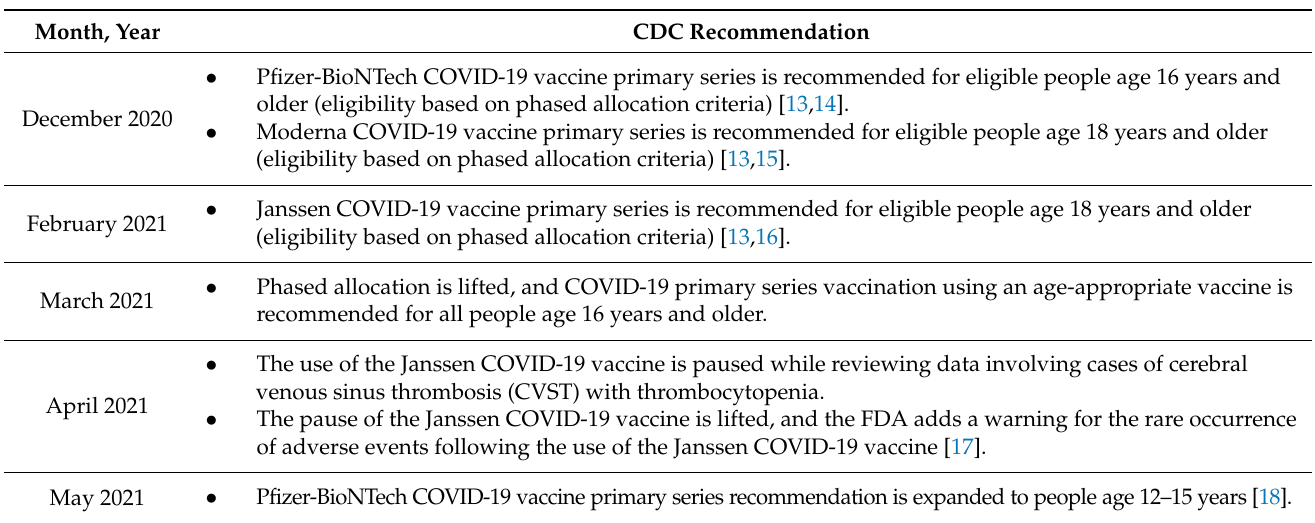
Figure 1. NIPINFO COVID-19 vaccine administration error inquiries by month, including total inquiries and incorrect dosage or product inquiries. Table 1. CDC COVID-19 vaccine recommendations published by month, December 2020 – April 2022.